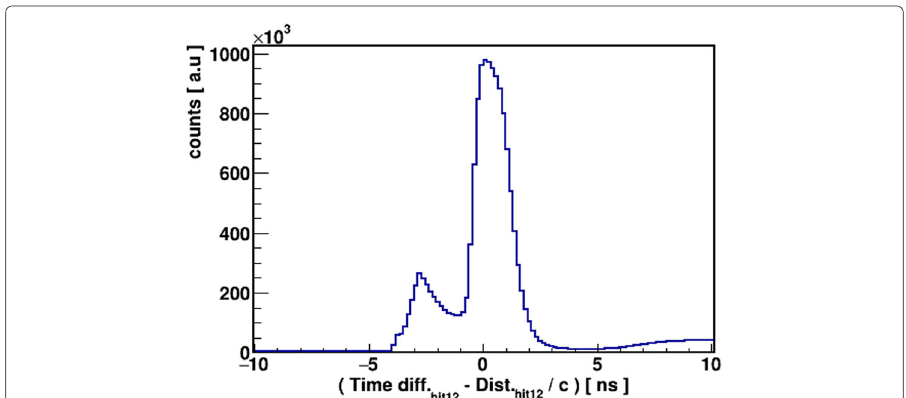
Fig. 9 Results of the S -test calculated between hit 1 and hit 2 in event-wise manner. For the true scattering of prompt photons, the value of the S test is chosen between − 0.5 and 0.75 ns. Small peak around S = − 3 ns is mainly due to the contribution from back-to-back annihilation photons. A slope starting at 5 ns is because of the time difference constraint between hit 1 and hit 3 (> 10